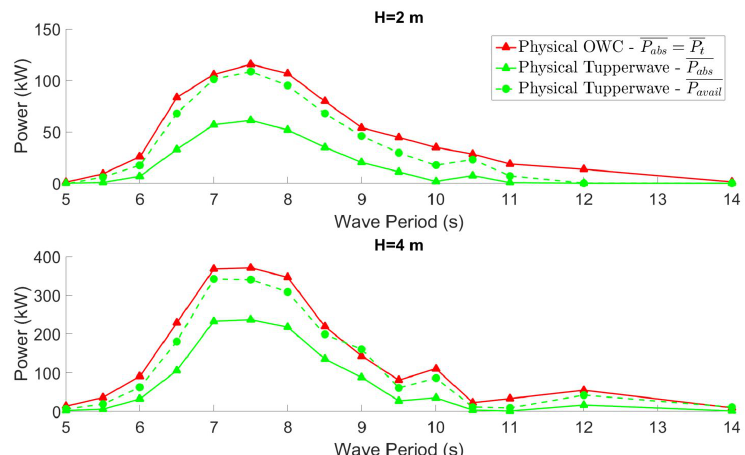
Figure 18. Average power absorbed from the waves P abs and pneumatic power available to the turbine P avail by the conventional OWC and the Tupperwave device in 2 and 4 m-high regular